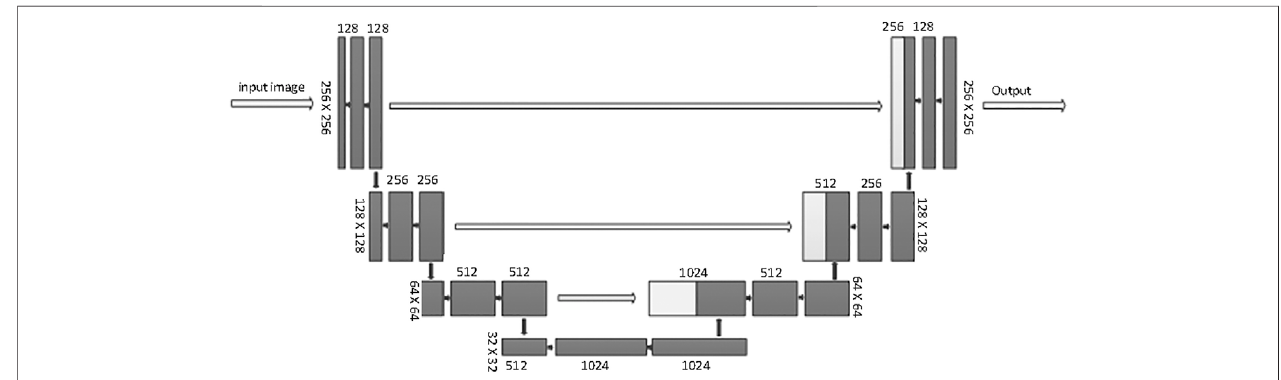
FIGURE 4 | Illustration of the U-Net architectures